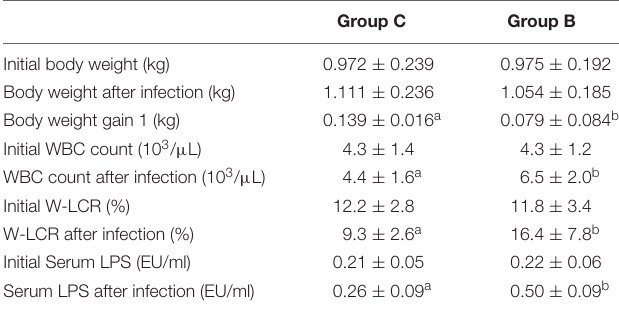
TABLE 1 | Body weight, body weight gain, WBC count, W-LCR, and serum LPS concentration of rabbits in different groups before and after Escherichia coli infection (Mean ± SD).